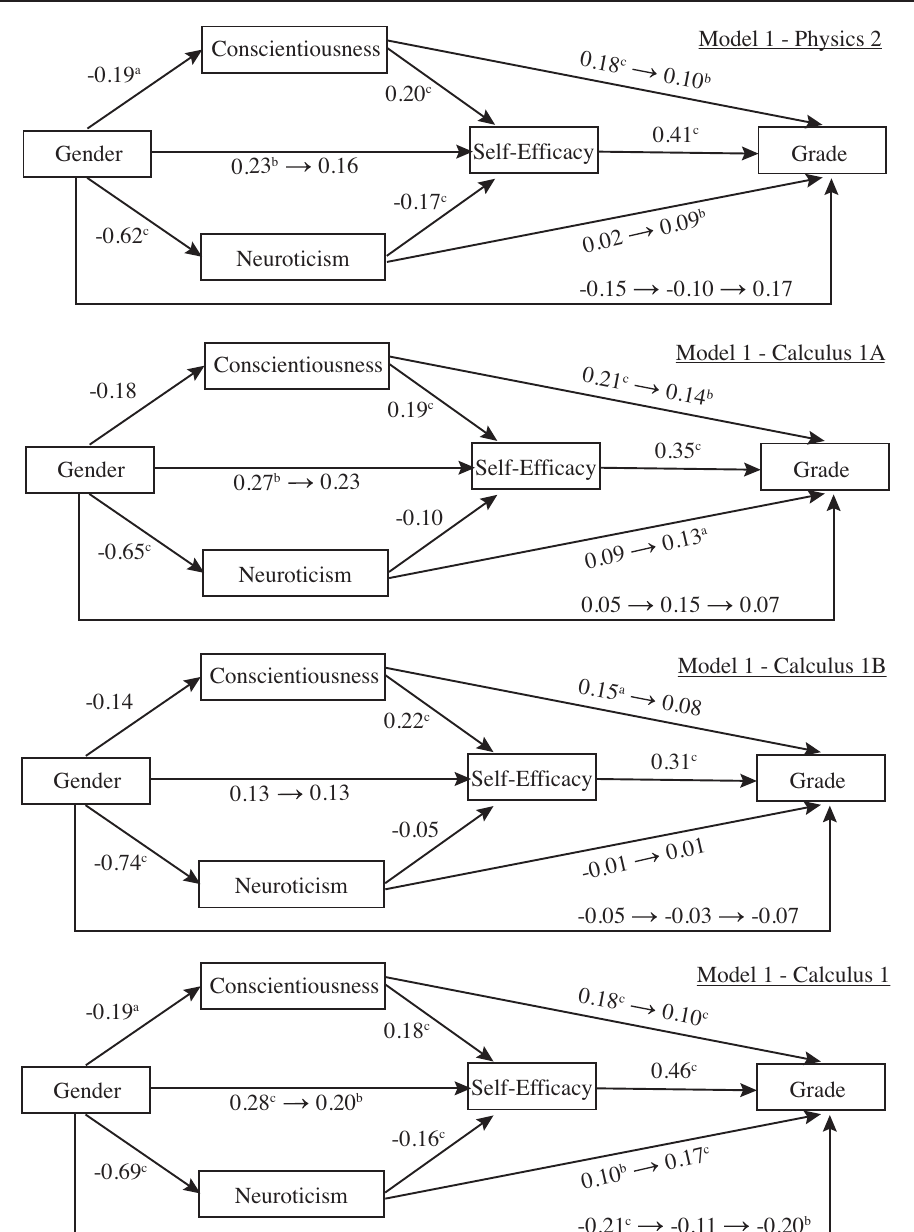
FIG. 4. Path models showing the relation of gender, personality, and self-efficacy for students in Physics 2, Calculus 1A, Calculus 1B, and Calculus 1. The number on each path is the value of the regression coefficient. The notation # 1 → # 2 shows the change in the coefficient before ( # 1 ) and after ( # 2 ) the addition of the mediating variables. Compare the figure with Fig. 2 for the symbolic variable related to each number. Note: “ a ” denotes p < 0 . 05 , “ b ” p < 0 . 01 , and “ c ” p < 0 . 001